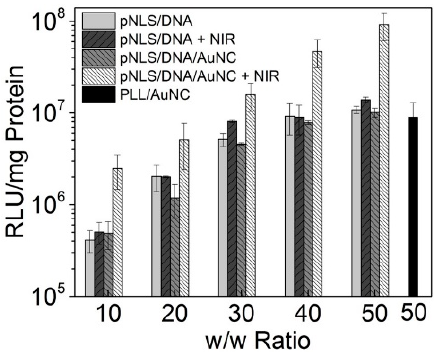
Figure 7. Luciferase expression in HeLa cells mediated by pNLS/DNA and pNLS/DNA/AuNC with or without NIR irradiation. PLL/DNA was used as control. Data are shown as mean ± S.D. ( n = 3).